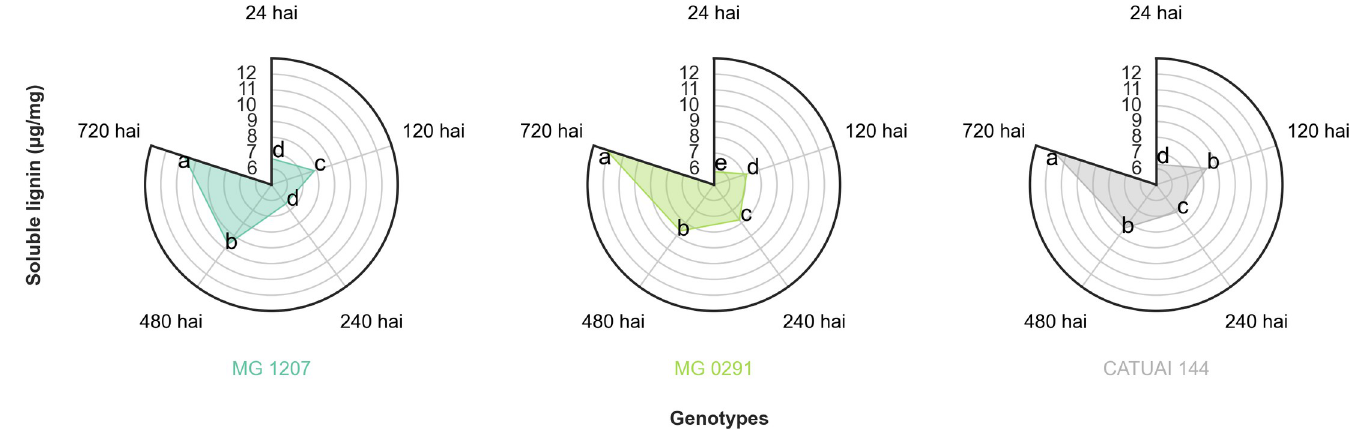
Fig 4. Soluble lignin content ( μ g/mg) in the leaves of MG 1207, MG 0291, and Catuaı´Vermelho IAC 144 collected at 24, 120, 240, 480, and 720 h after inoculation of C . coffeicola . � Averages followed by the same lowercase letter in the same genotype do not differ by the Tukey’s test (p � 0.05).